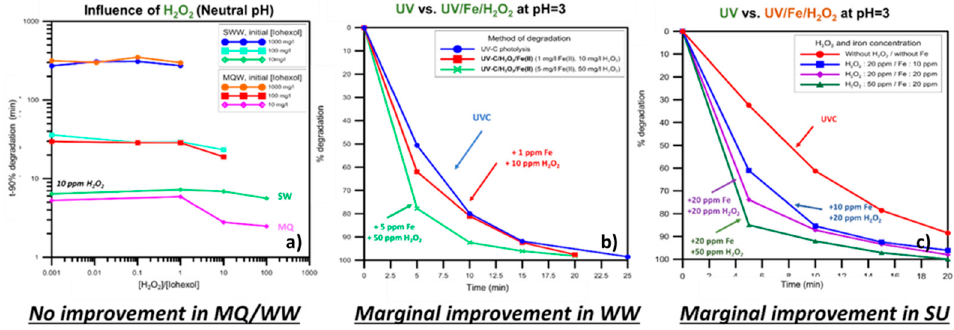
Figure 7. ICM Iohexol degradation by UV-based AOPs in: ( a ) water; ( b ) wastewater; and ( c ) urine. H 2 O 2 addition and Fe-assisted experiments, aided by acidification of the matrix hold minor improvement in degradation kinetics.